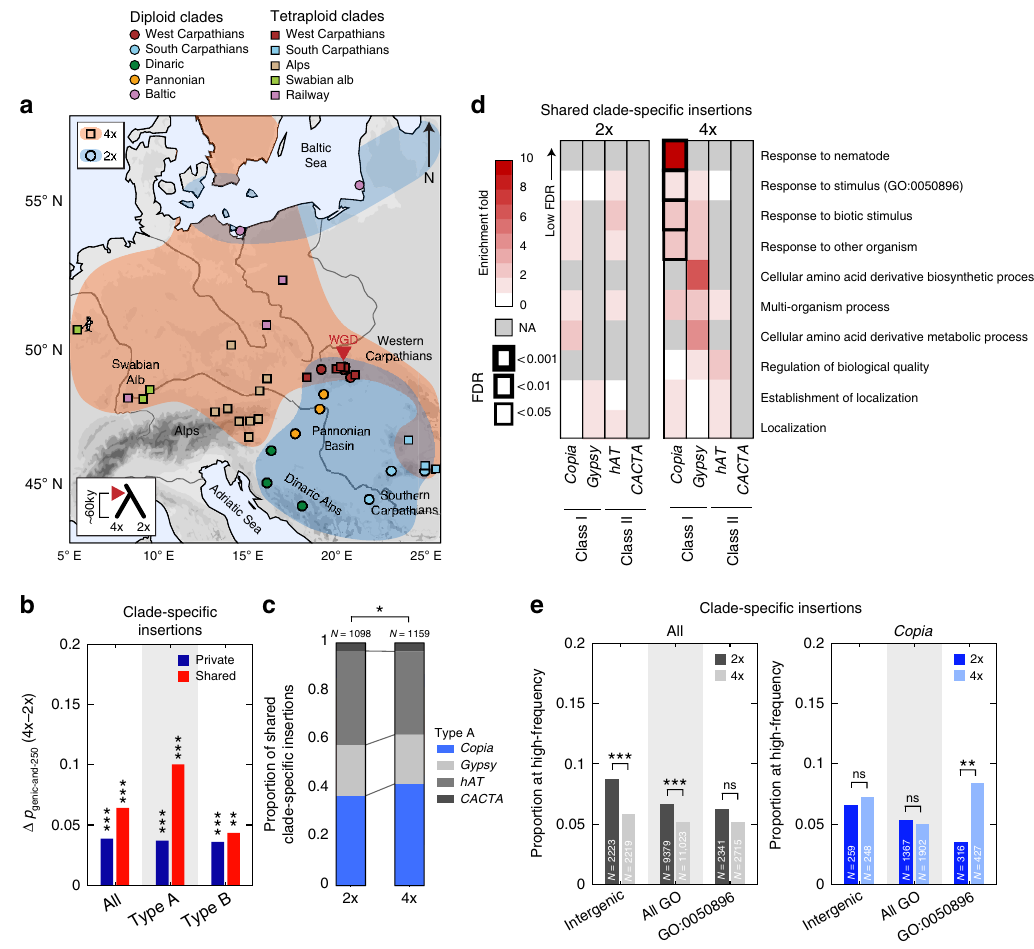
Fig. 4 Local positive selection on Copia genic insertions in tetraploids. a Map of the tetraploid and diploid populations colored by clade. b Difference between tetraploids and diploids of the proportion of genic and near-genic (<250 bp) insertions present in only 1 clade (clade-speci fi c) and private or shared within the clade for all, type A, and type B superfamilies with p -values of χ 2 test between ploidies (type A: 2x n = 4597 private and 1098 shared, 4x n = 5524 private and 1159 shared; type B: 2x n = 8921 private and 2563 shared, 4x n = 9646 private and 2335 shared). c Proportion among shared clade- speci fi c type A insertions from each type A superfamily in diploids and tetraploids with p -value of χ 2 test between ploidies. d GO enrichments in diploids and tetraploids among genes carrying or nearby shared clade-speci fi c insertions for type A TE superfamilies. e Proportion in diploids and tetraploids of clade-speci fi c insertions at locally high frequencies (shared by three or more individuals) within intergenic regions, within or near genes, or within or near stimulus response genes (GO:0050896) for all superfamilies or only Copia insertions with p -values of χ 2 test between ploidies . p < 0.001: * **; p < 0.01: **; p < 0.05: *; p ≥ 0.05: ns. The source data underlying Fig. 4b – e are provided as a Source Data fi